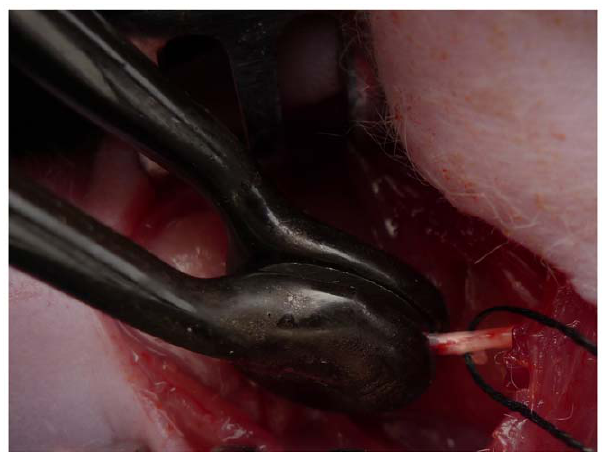
Figure 6. The IRE device clamping the exposed right sciatic